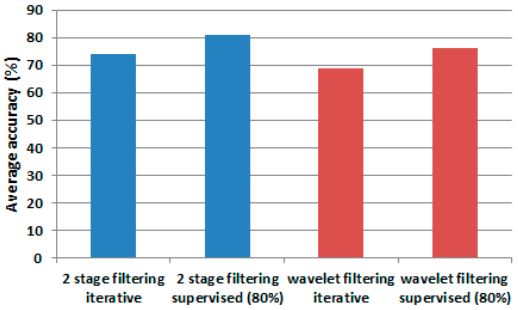
Figure 9. Average accuracy. Bars in blue represent average accuracy when two-stage filtering is used. Bars in red represent the results for single-stage wavelet filtering.